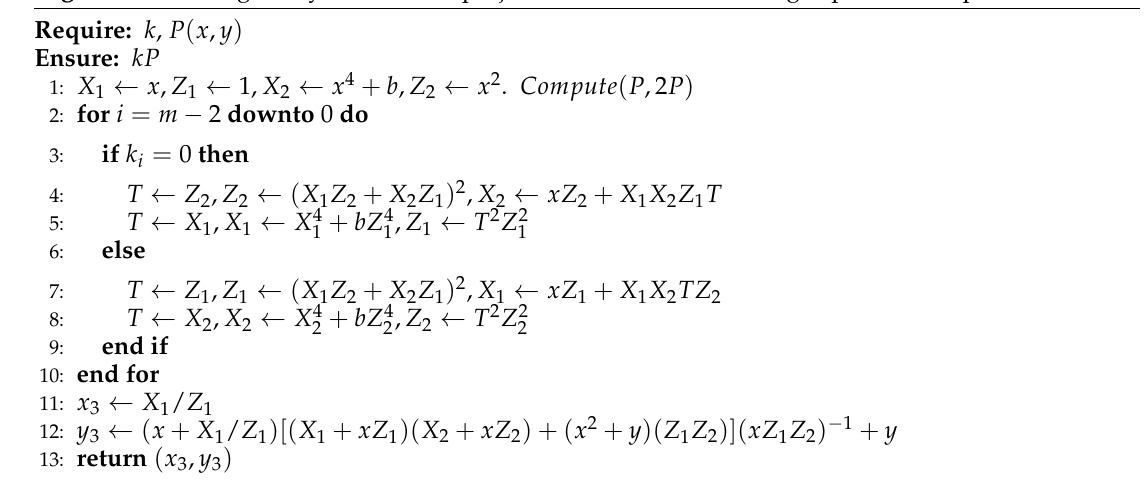
Algorithm 2 Montgomery ladder over projective coordinates, making explicit field